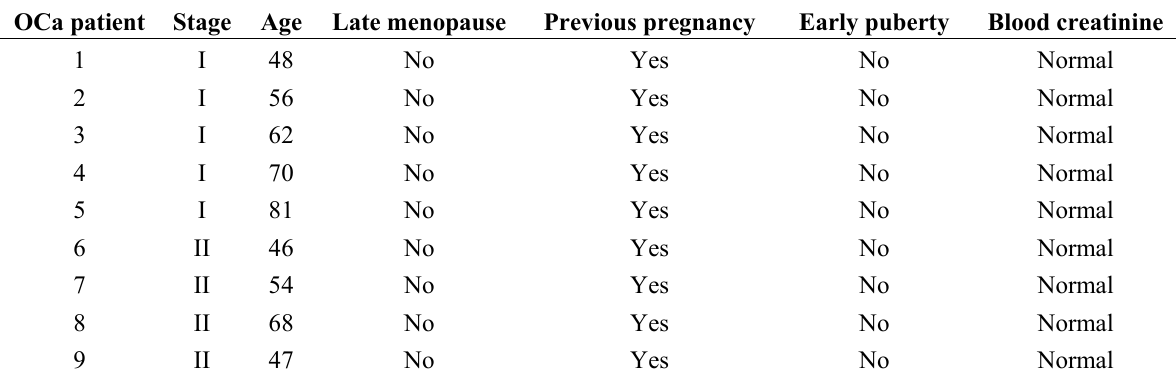
Table 3. Clinical data of OCa patients involved in the